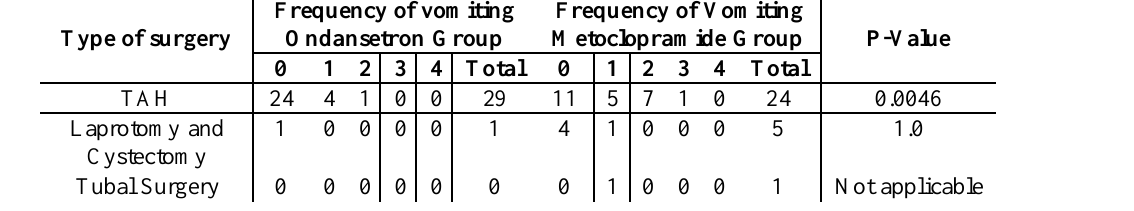
t=-0.105, p=0.92 Table V : Chart showing number of patients having different frequencies of